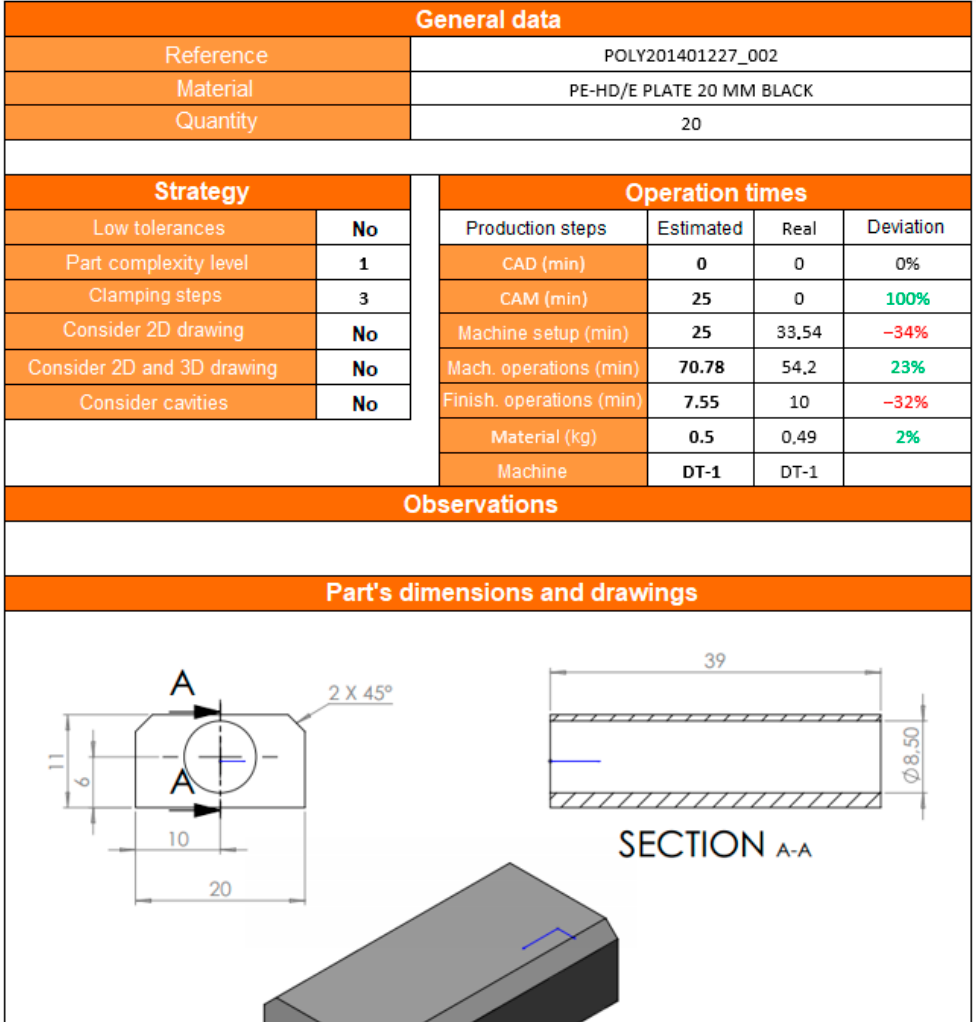
Figure 7. MS Excel ® interface of the developed cost estimation tool.